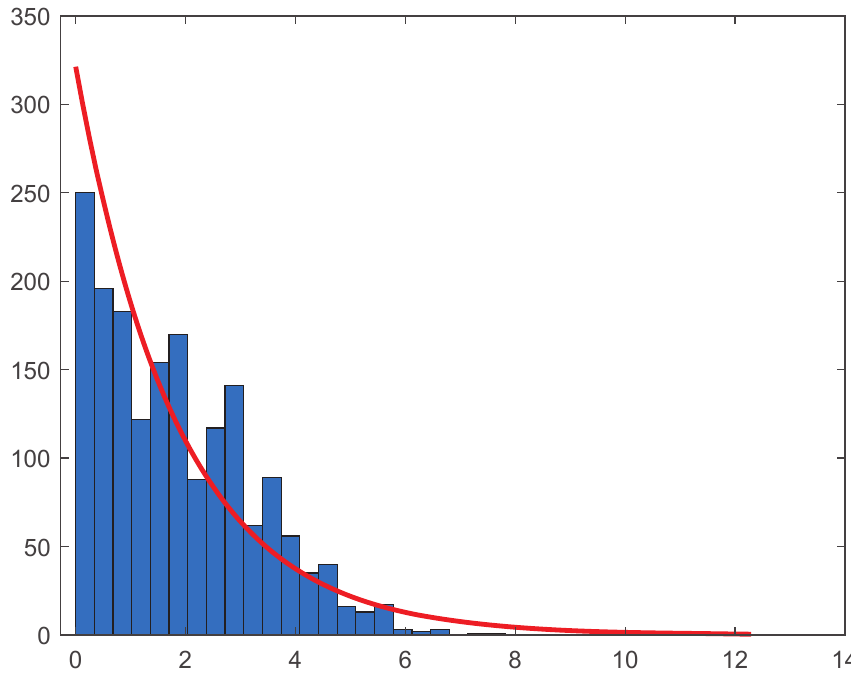
Figure 3. Exponential fit of temperature distribution—tail beyond 90% percentile.